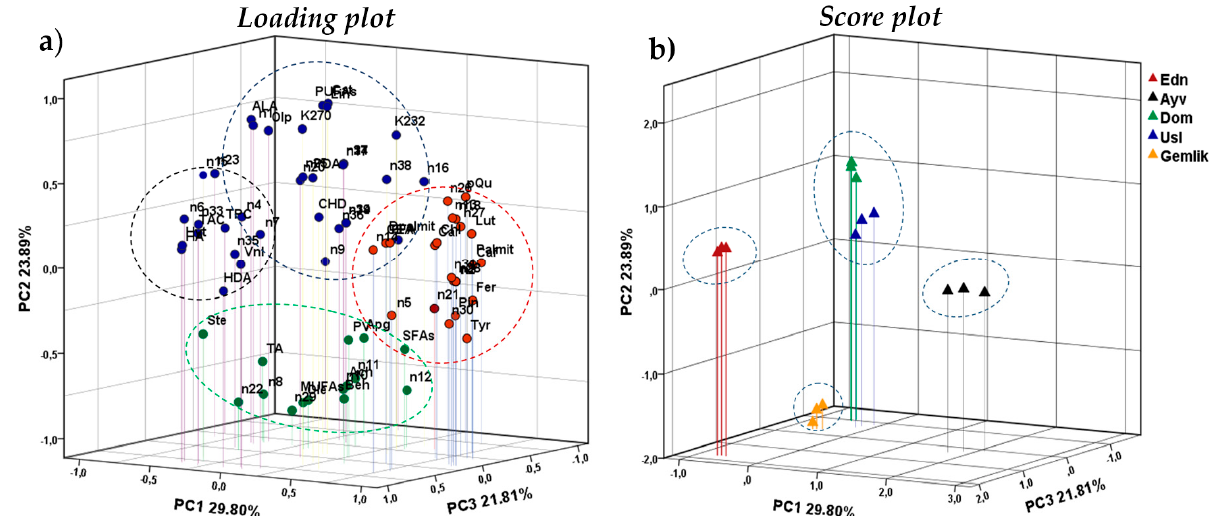
Figure 4. Loading plot ( a ) and score plot ( b ) of the three first components of PCA based on analyzed parameters of samples. Abbreviations: Edn, Edincik; Ayv, Ayval ı k; Dom, Domat; Usl, Uslu; FFA, Free fatty acid; MUFA, Monounsaturated fatty acid; PUFA, Polyunsaturated fatty acid; SFA, Saturated fatty acid; PV, Peroxide value; TAC, Total antioxidant capacity; TPC, Total phenolic content; ALA, linolenic acid; PDA, Pentadecanoic acid; Palmit, Palmitic acid; Dpalmit, 9-Hexadecenoic acid; HDA, Heptadecanoic acid, CHD, 10-Heptadecanoic acid, Ste, Stearic acid; Ole, Oleic acid; Lin, Linoleic Acid, Ach, Eicosanoic acid; CEA, 11-Eicosenoic acid; HA, Heneicosanoic acid; Beh, Docosanoic acid; n, Compound numbered from 1 to 38 in Table 4. The components/properties in the red, green, and black cycles in the Loading plot contributed to the separation of Ayval ı k, Gemlik and Edincik oils, respectively, while those in the blue circle contributed to the separation of Domat and Uslu oils from others.